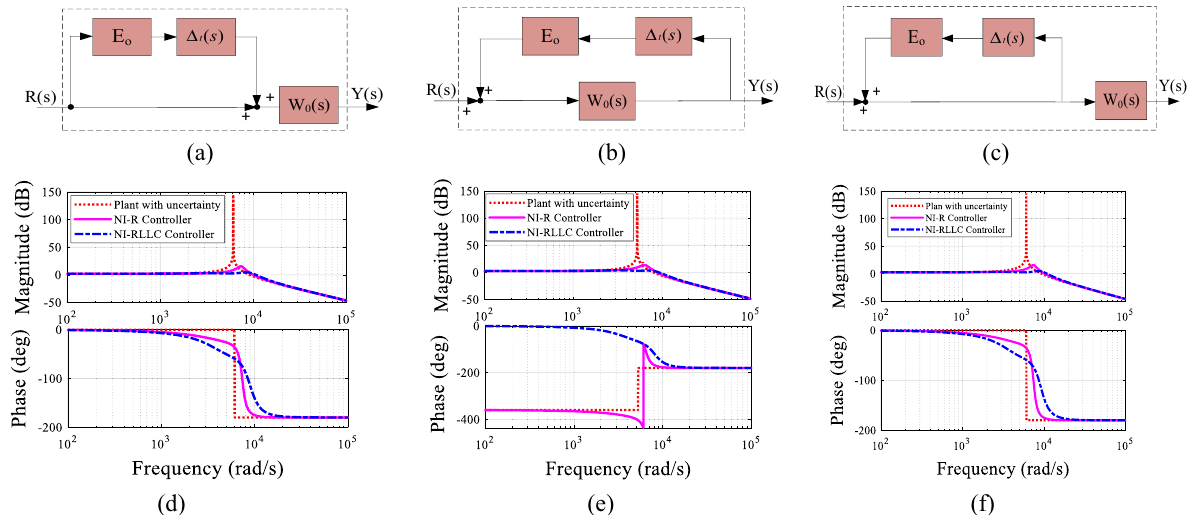
Fig. 8 Block diagram of a multiplicative input uncertainty b inverse additive uncertainty and c inverse multiplicative input uncertainty for single‑phase MG system. Bode plot of d multiplicative input uncertainty e inverse additive uncertainty and f inverse multiplicative input uncertainty for single‑phase MG system